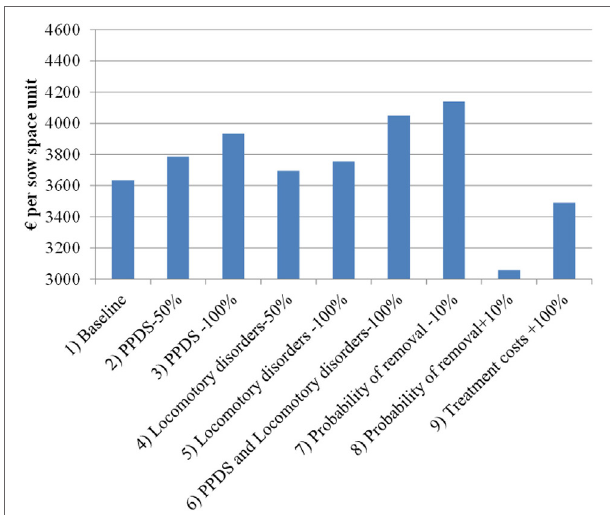
FigUre 5 | Return on fixed costs (€ per sow space unit) in the sensitivity analysis scenarios simulated by the dynamic programming model. PPDS, postpartum dysgalactia